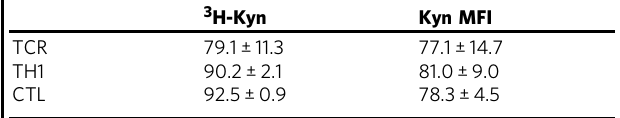
Table 1 Percentage of kynurenine uptake blocked by BCH Thetable shows the percentageof kynurenine uptake blockedby the System L inhibitor, BCH as measured by 3 H-Kyn uptake or 450nm fl uorescence emission. Data from CTLs, TH1 and 24h CD3/CD28 stimulated T cells (TCR) are shown. Data (±s.d.) are pooled from from six (CTL) or four (TH1 and TCR)